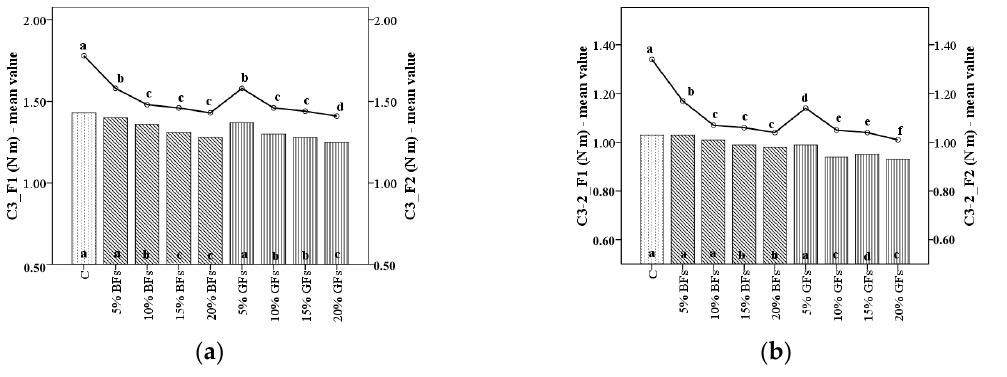
Figure 3. C3 torque ( a ) and difference between torques C3 and C2 (C3-2) ( b ) of WF (C) and flaxseed–wheat composite flours formulated by adding different levels (5%,10%,15% and 20%) of brown flaxseed (BFs) and golden flaxseed flour (GFs) in two types of flour—F1 and F2. Different letters indicate significant differences ( p < 0.05) between samples.